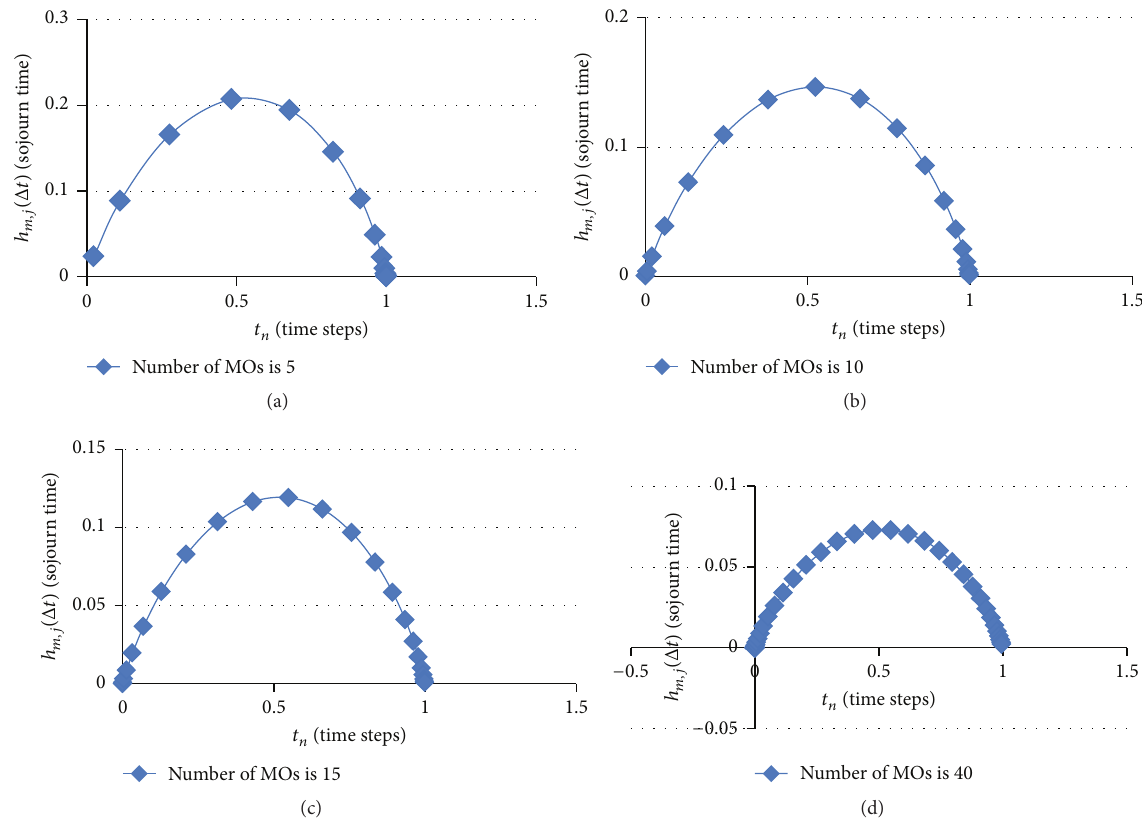
Figure 3: Poisson distributions of the uncertainty entropies of 𝑗 th flow and Δ𝑡 time of MO (moving object) spent in the Mix-Zone. Number of MOs predicted by attacker 𝐴 at egress points varies from (a) to (d).